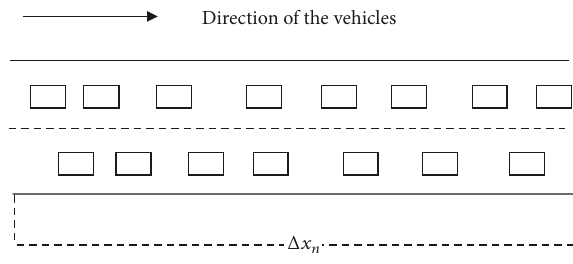
Figure 4: The distribution of floating cars on the freeway.